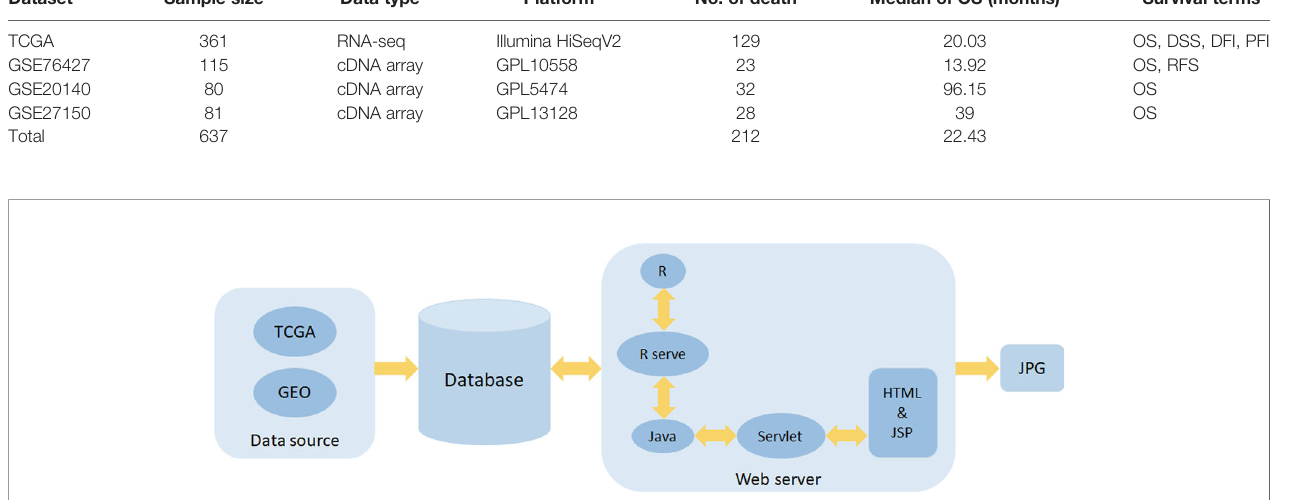
FIGURE 1 | Flowchart of web server